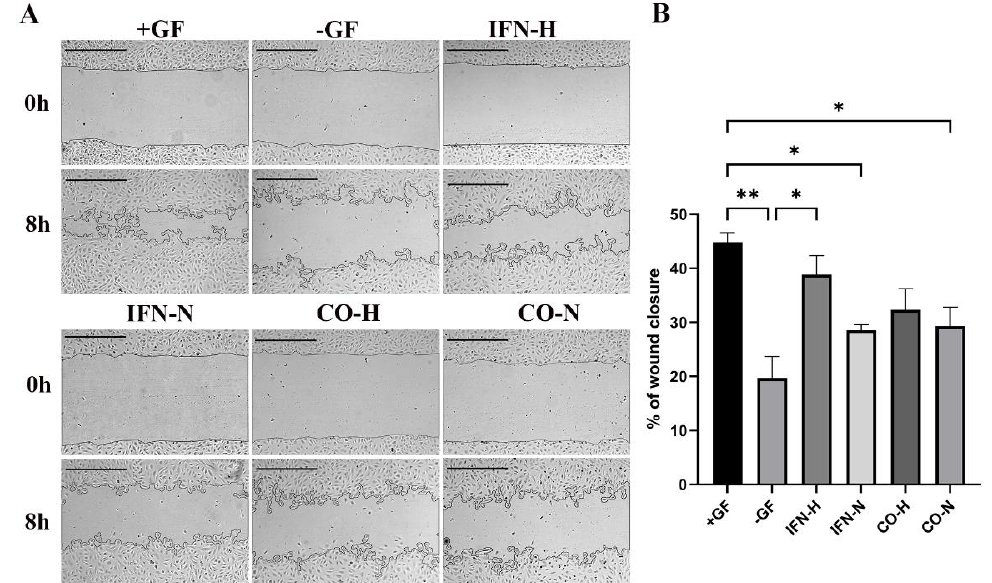
Figure 6. Wound healing assay of HUVECs incubated with differently pre-conditioned iMSCs secretomes. HUVECs cultured with differently pre-conditioned iMSCs secretomes, growth factors (+GF, positive group), or without growth factors ( − GF, negative control group). ( A ) Representative images (5x magnification, scale bar = 500 µm) of the scratched area were taken using brightfield microscopy at 0 and 8 h after cell seeding. ( B ) Quantification of the wound closure by HUVECs cultured with pre-conditioned iMSCs secretomes. Values represent means ± SEM from three independent experiments (* p < 0.05, ** p < 0.01).